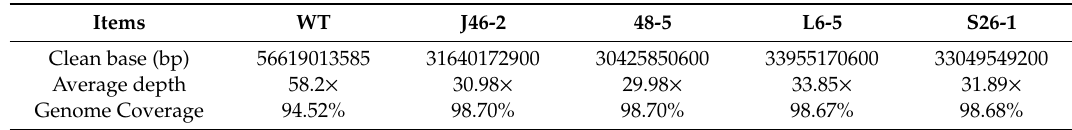
Table 2. Whole-genome resequencing of the wild type and four ethyl methanesulfonate-induced eggplant mutants.